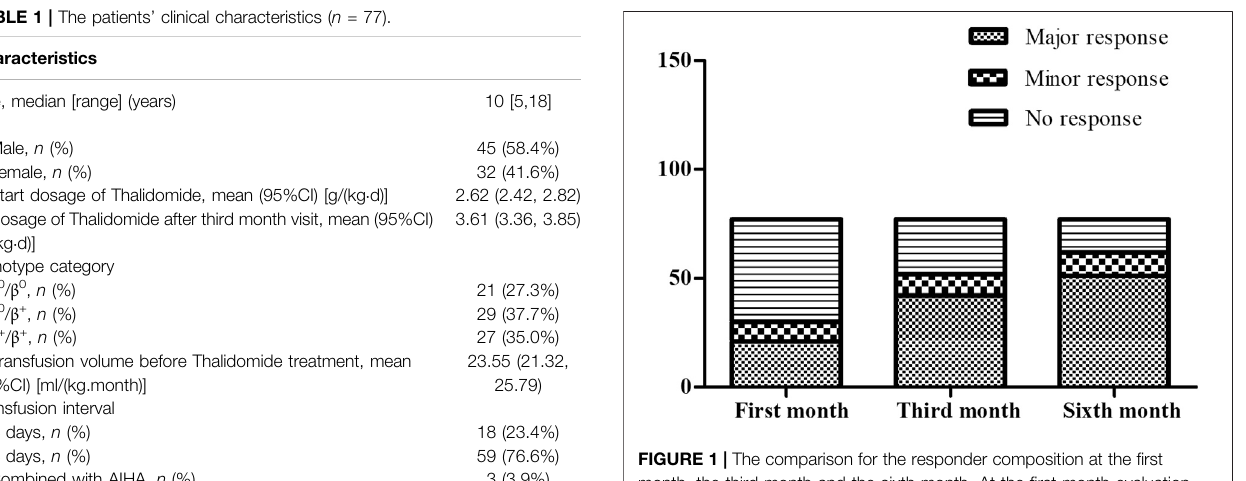
FIGURE 1 | The comparison for the responder composition at the fi rst month, the third month and the sixth month. At the fi rst month evaluation, there were 21 major responders, nine minor responder and 47 non- responders. At the third month evaluation, there were 42 major responders, 10 minor responder and 25 non-responders. At the sixth month evaluation, there were 51 major responders, 11 minor responder and 15 non-